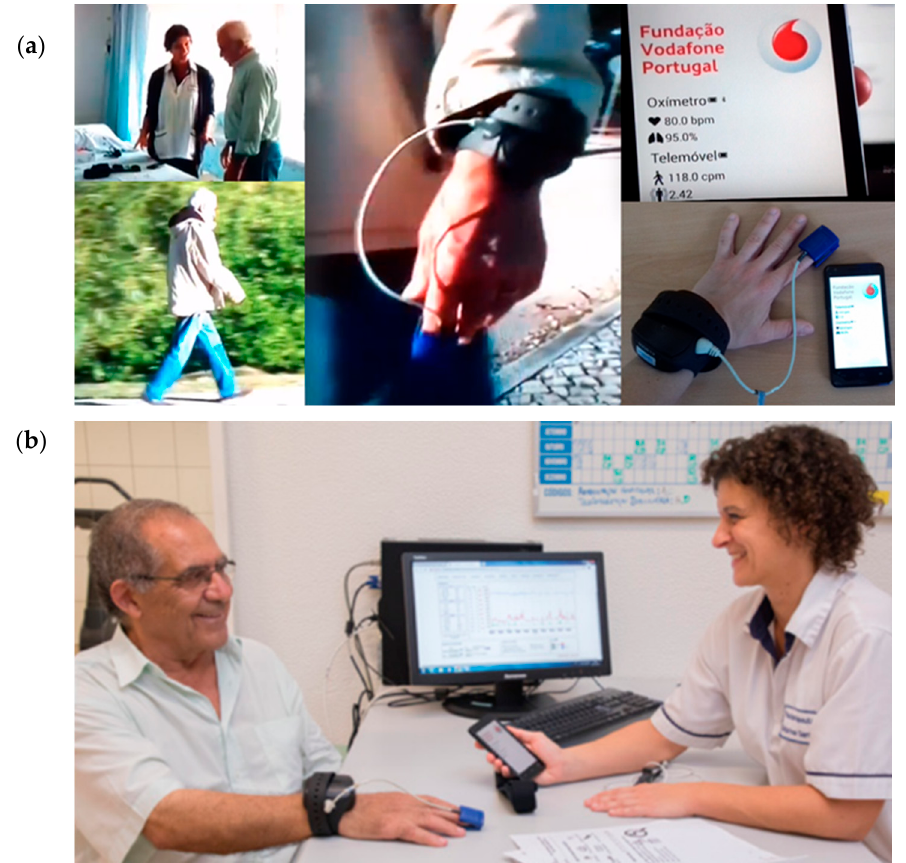
Figure 1. ( a ) Patient receiving instructions on how to use the SMARTREAB equipment: an Android smartphone with an accelerometer (to be used at waist level using a belt with an inside pocket), connected by Bluetooth to a portable oximeter with finger or ear sensor. During telemonitoring patients have access to the smartphone screen information indicating % of transcutaneous oxygen saturation, bpm of heart rate and metabolic equivalent of task (MET) of physical activity. ( b ) Together patient and physiotherapist analyze retrospective telemonitoring data integrating important input for the design of the patient-tailored pulmonary rehabilitation. (The patients and healthcare professional shown consented to be photographed and such images to be used for research publication purposes).